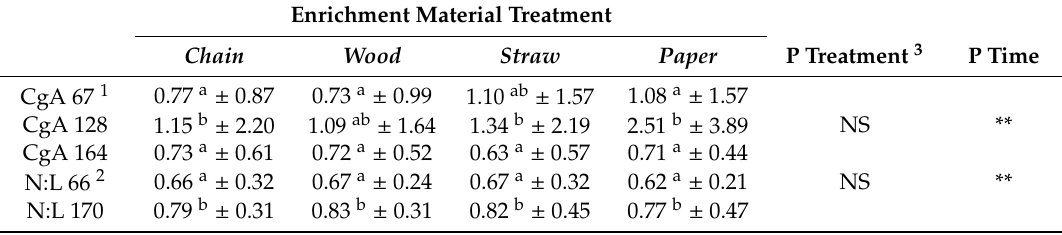
Table 2. The Mean (and standard deviations) of the various physiological indicators of welfare for the 4 types of enrichment over time.